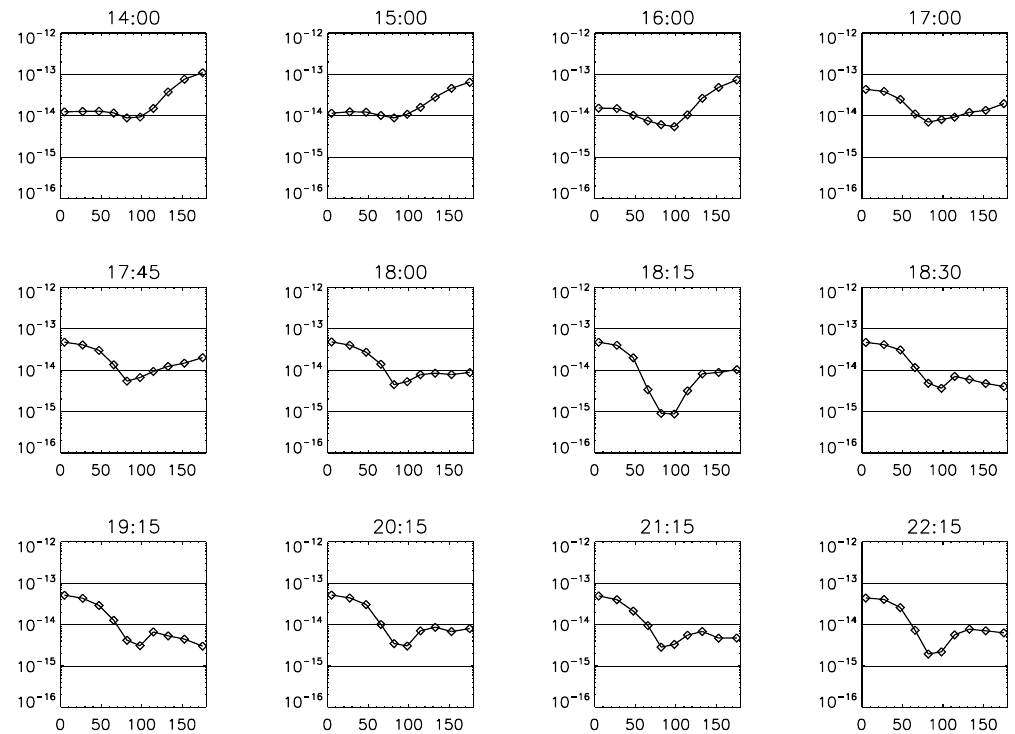
Fig. 4. Wind observation: Electron pitch angle distributions for the low-energy Electron Electrostatic Analyzer (EESA-L) on the 3DP instru- ment energy channel 250eV for different times labeled above each